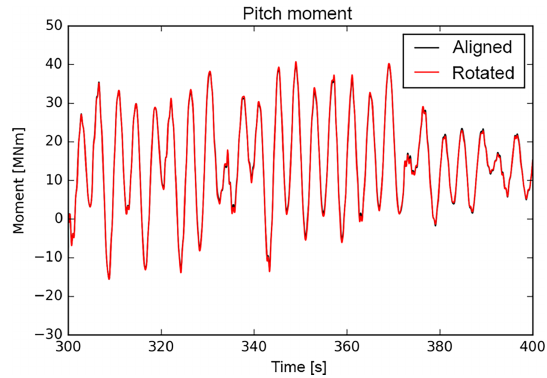
Figure 26. Pitch moment for wind–wave direction 0 and 45 ◦ .